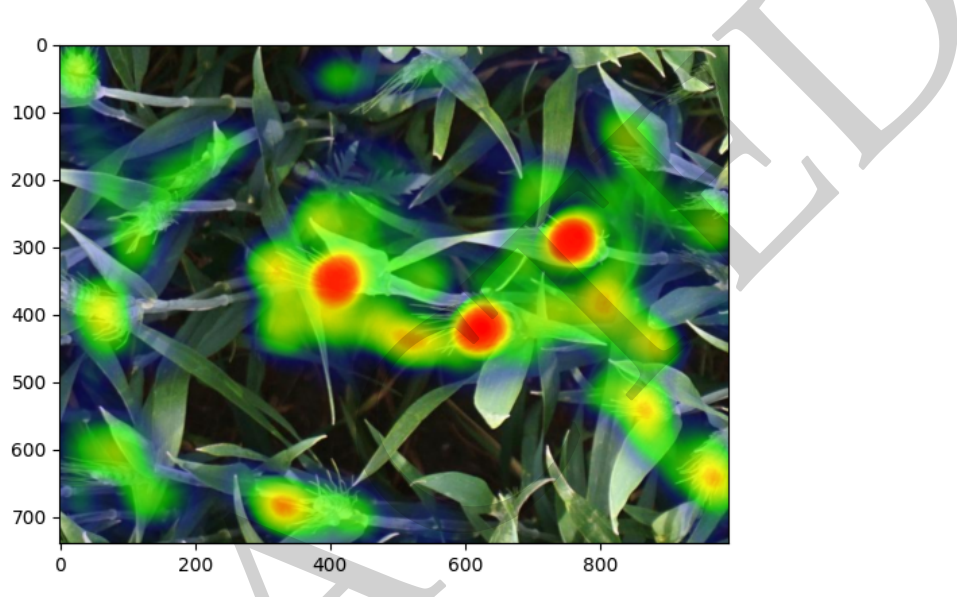
Figure 6. Illustration of human visual